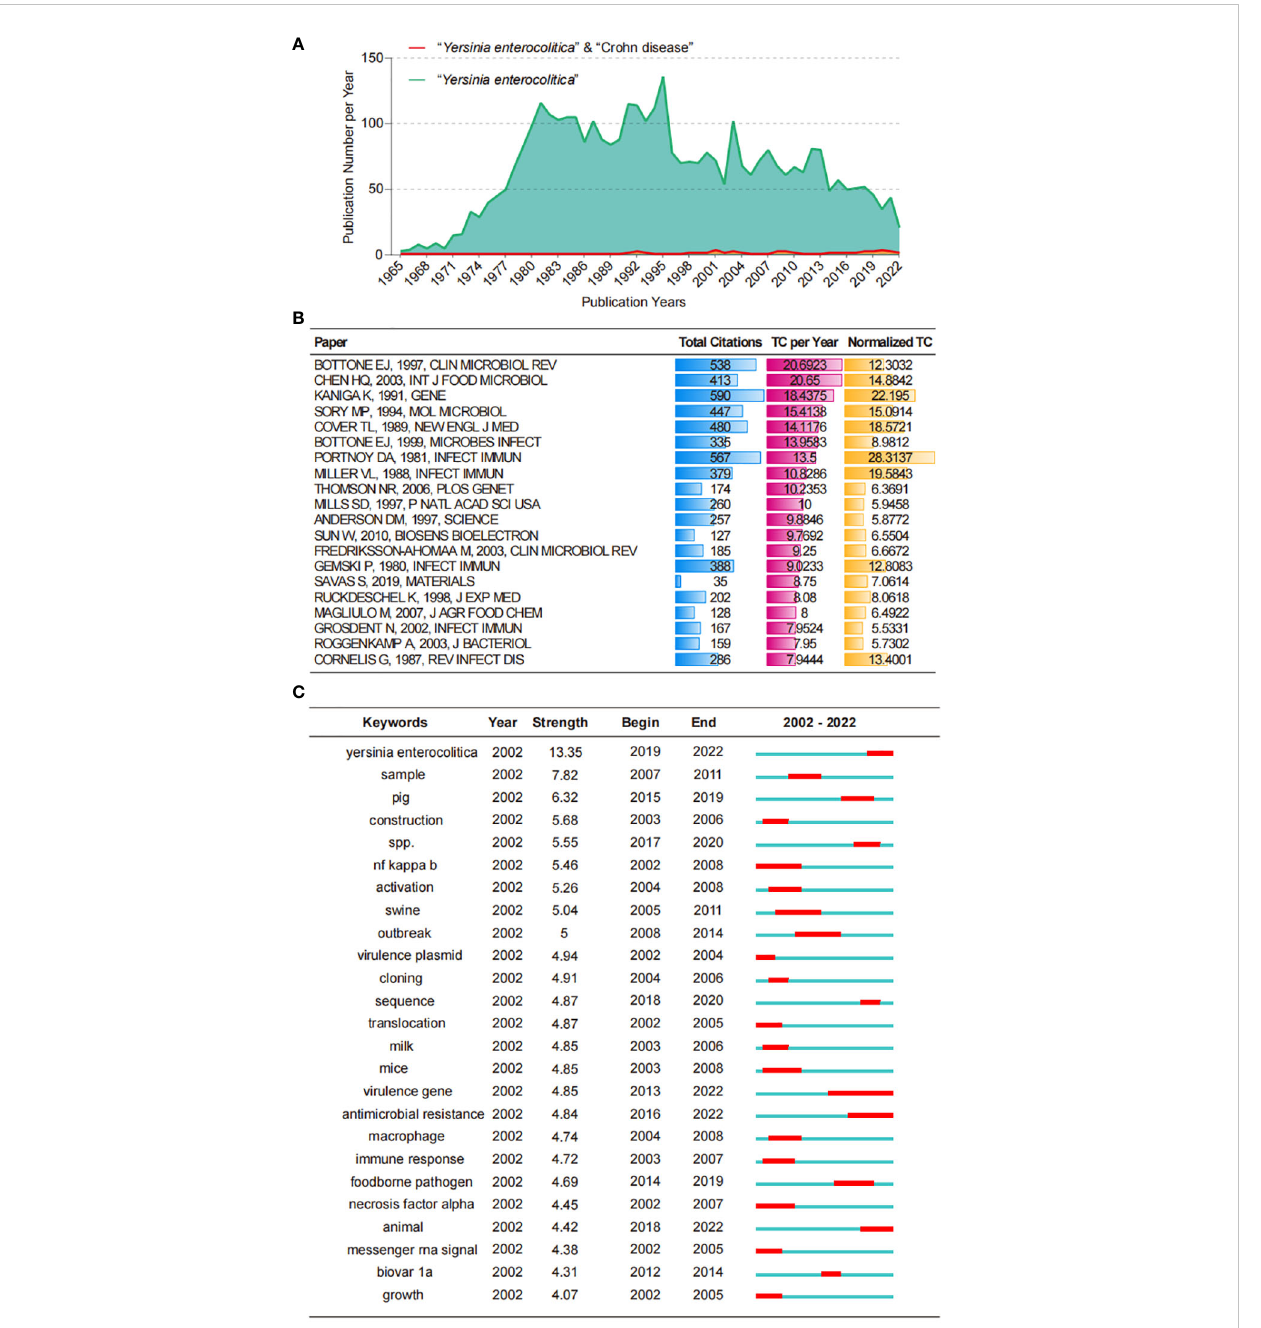
FIGURE 1 Bibliometric analysis of WoS core database output. (A) The growth productive trends of the topic “ Y. enterocolitica ” and “ Y. enterocolitica ” & “ Crohn disease ” research from 1900 to 2022. (B) Top 20 most cited papers in the topic “ Y. enterocolitica ” research from 1900 to 2022. (C) Top 25 Keywords with the Strongest Citation Bursts in the topic “ Y. enterocolitica ” research from 2002 to 2022. WoS, Web of